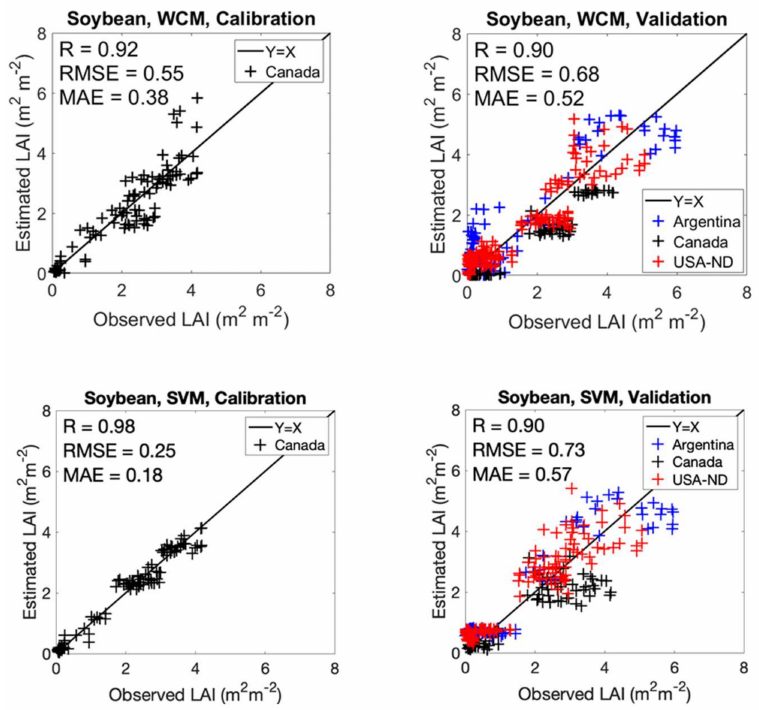
Figure 4. The calibration and validation results for soybeans for three JECAM sites (Argentina, Canada, and